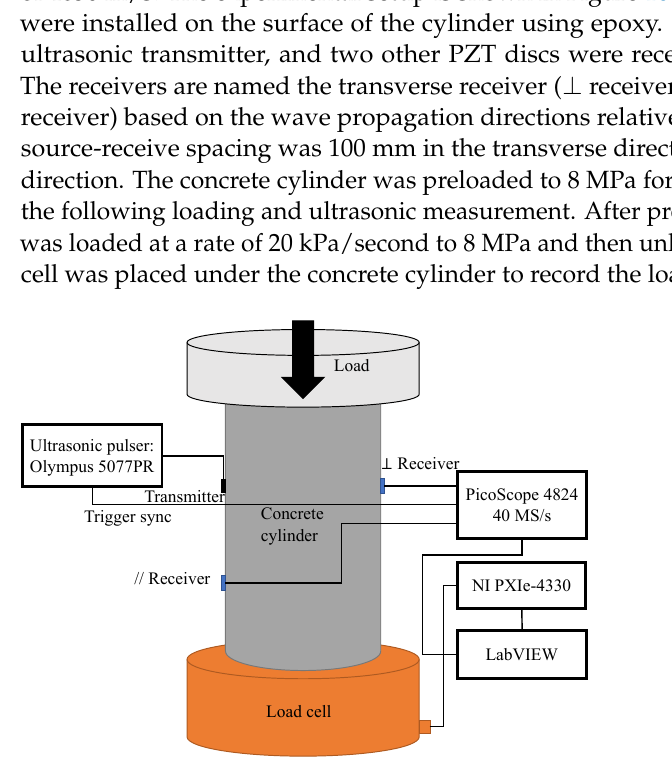
Figure 10. Experimental setup of uniaxial loading test on a 100 mm × 200 mm concrete cylinder.